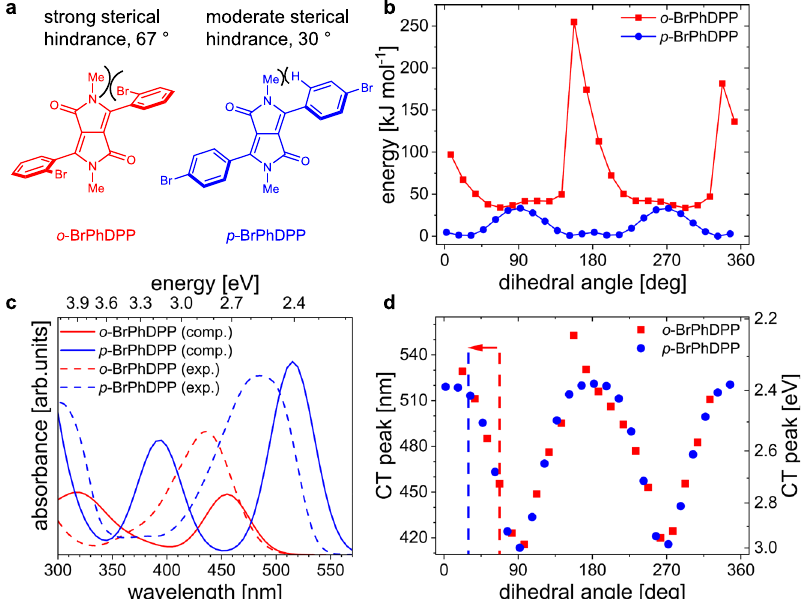
Fig. 2 Theoretical evaluation of ortho -substitution in PhDPP. a Molecular structures of o -BrPhDPP (red) and p -BrPhDPP (blue). b Computed torsion potentials for the rotation of the BrPh group. c Simulated UV-vis spectra for the relaxed structures in the gas phase and experimental UV-vis spectra in DMF (0.035 mmol L − 1 ). d Variation of the simulated CT-peak position with the dihedral angle. Dashed lines indicate equilibrium geometries (minima in the torsion potentials in b ), and the arrow the direction if an external force is agreement, in particular for the relative shift of the low energy bands wavelength of the CT band with varying dihedral angles. Deviations of o -BrPhDPP and p -BrPhDPP. In theory and experiment, these of 15° and 30° from the equilibrium geometry shift the CT band by bands differ by 0.31 eV and 0.30 eV, respectively. The possibility to 30 nm and 55 nm, respectively. This estimation con fi rms the detect geometric changes by optical changes (or vice versa) can now diphenyl DPP system as a promising candidate for an experimental be inferred from Fig. 2d, which displays the change of the absorption realization of a DA spring.